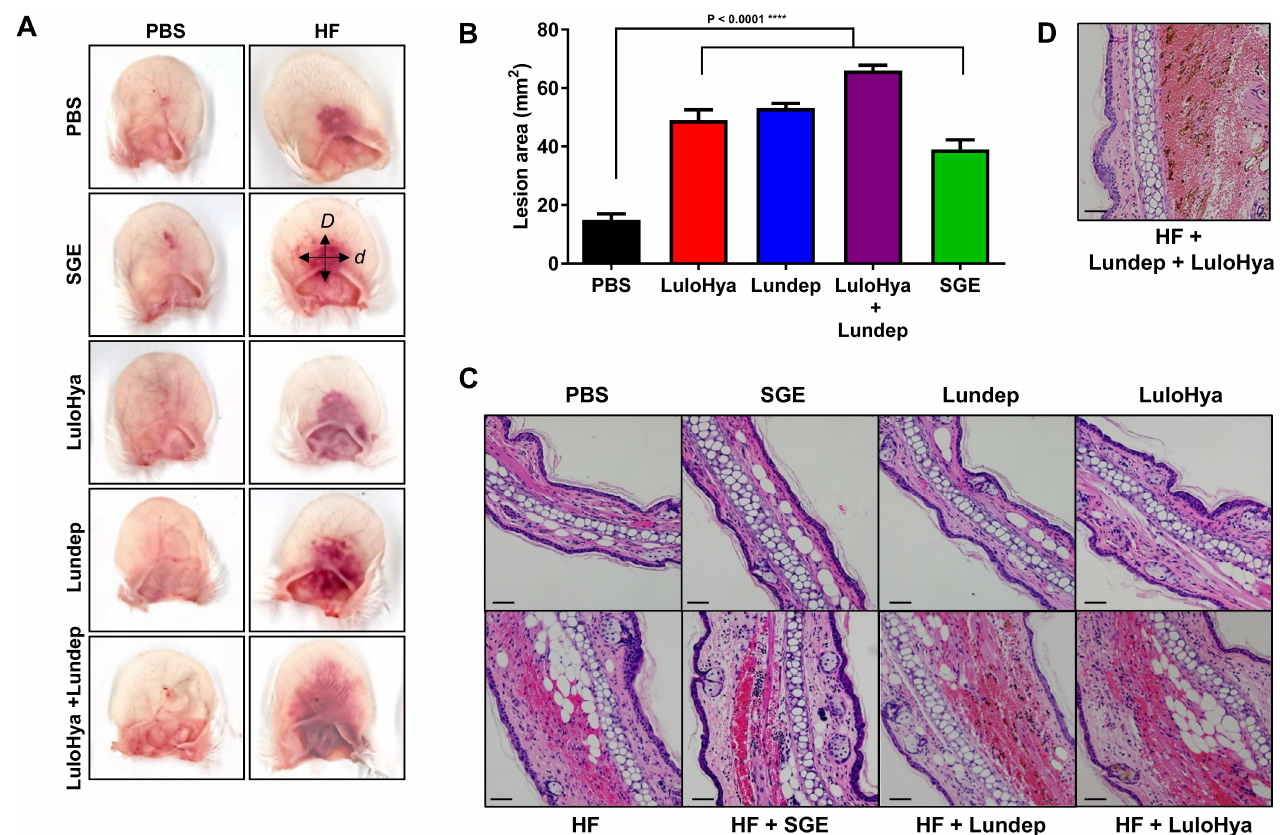
Fig 5. LuloHya and Lundep enhance dermonecrotic lesions caused by HF injection. (A) Ears of animals injected intradermally with 3 μ g of HF along with SGE (equivalent to 2 SG), 10 μ g of LuloHya, 10 μ g of Lundep or a combination of 5 μ g of LuloHya and Lundep (HF column) showed larger lesions than ears injected with HF and PBS. Left column pictures (PBS) show mice ears injected with SGE, LuloHya, Lundep and the combination of both proteins in the absence of HF. Two hours after injection, ears were excised and measurements of the hemorrhage area were taken. (B) Lesion area in all groups injected along HF was significantly greater than control (mice ears injected with PBS and HF). The lesion area (mm) was calculated as follows, Area = D (cid:3) d (cid:3) p longest and d the smallest lesion diameter. Multiple comparisons were done by one-way ANOVA ( (cid:3)(cid:3)(cid:3)(cid:3) : p < 0.0001). Bars indicate SEM. (C) Histological sections of mice ears inoculated with HF were characterized by moderate expansion of the sub-epithelial tissues by a mixture of edema fluid and infiltrating leukocytes. Ear sections inoculated with HF and SGE, LuloHya or Lundep showed acute hemorrhage and inflammation. Mice ears from control groups (without HF) were within normal histological limits. (D) Histological ear sections from mice inoculated with HF and both recombinant proteins LuloHya and Lundep showed greater areas of hemorrhage and edema than the inoculation of HF with the recombinant proteins separately. Bar scales indicate 50 μ m.